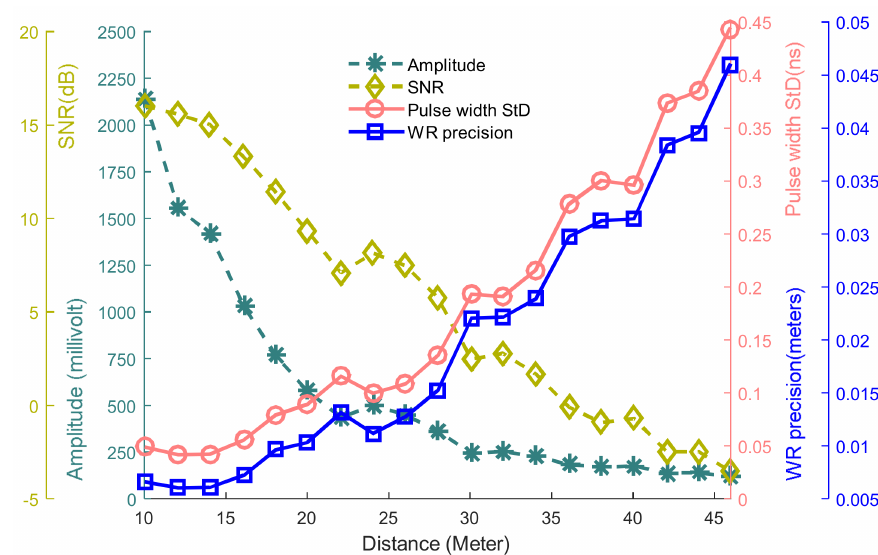
Figure 11. Waveform characteristics influencing on ranging